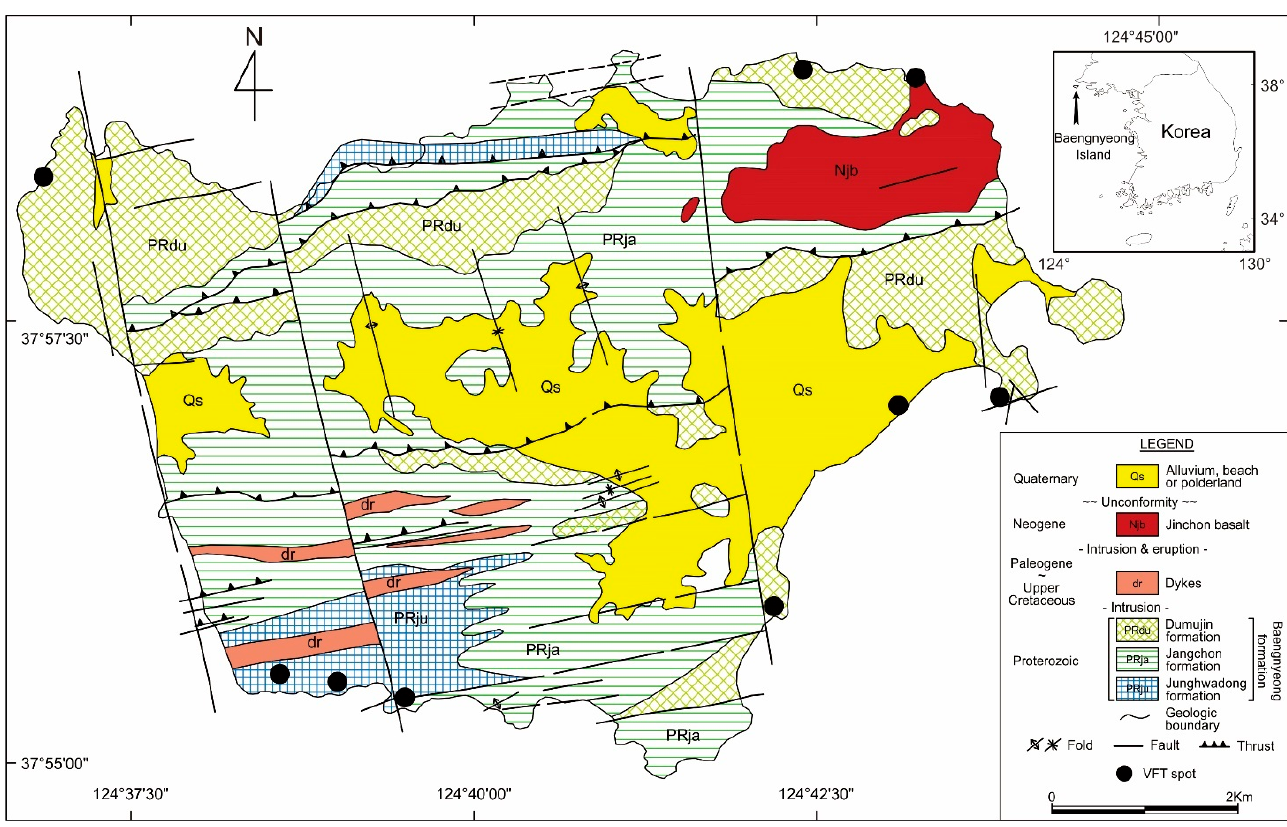
Figure 1. Geologic map of Baengnyeong Island with virtual field trip (VFT) locations [16]. In the 1:1,000,000 scale geological map of the Korea Institute of Geoscience and Min- eral Resources (KIGAM), the metasedimentary strata in Baengnyeong Island are indicated as Late Proterozoic (Neoproterozoic) [16]. However, these strata are indicated as Mid to Late Proterozoic in the 1:1,000,000 geological map developed by the Institute of Geol- ogy of North Korea [17]. The strata and rocks found in Baengnyeong Island largely fall into 4 categories [15]: (1) Low-grade metamorphic metasedimentary rocks that correlate with part of the Sangwon System (Baengnyeong group), (2) Age-unknown dikes that intrude into those metasedimentary rocks, (3) Cenozoic basalts and (4) Unconsolidated Quaternary